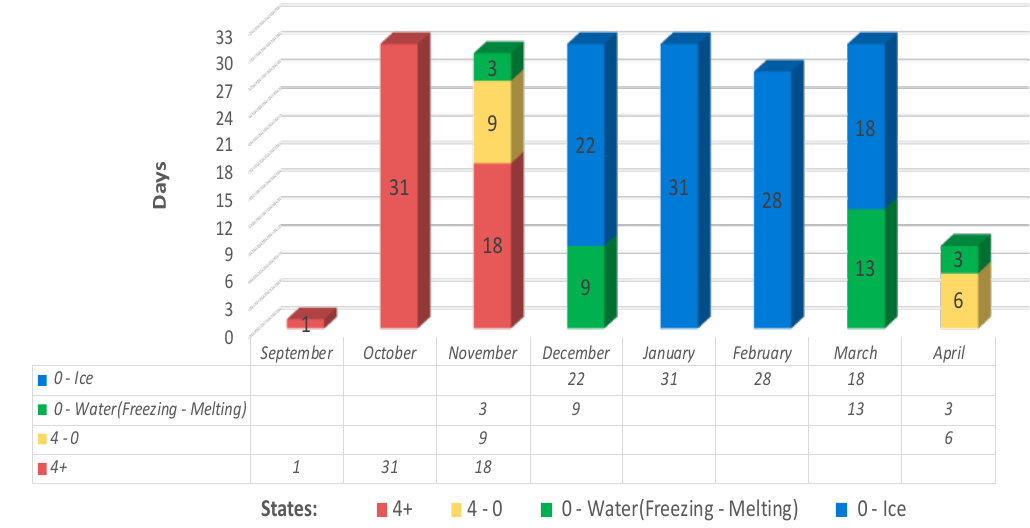
Figure 13. Ice storage states of t2—middle position.